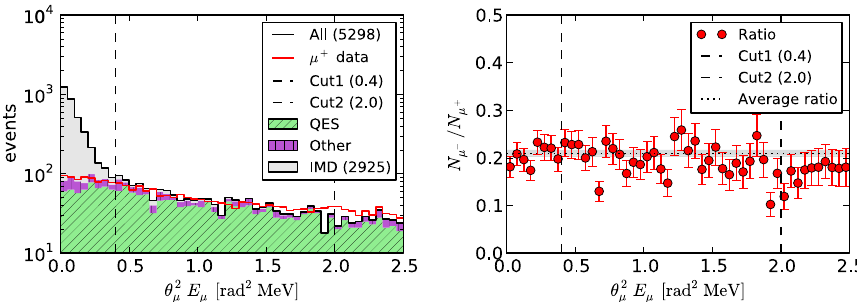
FIG. 12. The left plot shows distributions over (cid:1) 2 (cid:3) E (cid:3) for the (cid:3) (cid:1) beam sample. The leptonic events histogram is filled with solid gray, the hadronic events histogram is hatched, and the total spectrum is in black. The two cuts bounding the normalization region (cid:2) are drawn with a dashed line. The red line indicates the normalized (cid:3) þ histogram. The right plot shows the ratio of the (cid:3) (cid:1) histogram and the (cid:3) þ histogram over (cid:1) 2 (cid:3) E (cid:3) . The errors are statistical and the bars correspond to 1 (cid:8) . The horizontal dotted line indicates the normalization